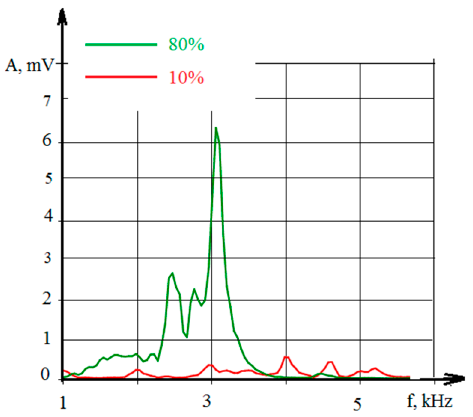
Figure 17. Comparison of the VA spectra of signals accompanying the operation of discharge pulses with different duty cycles: pulse widths of 10% and 80%.